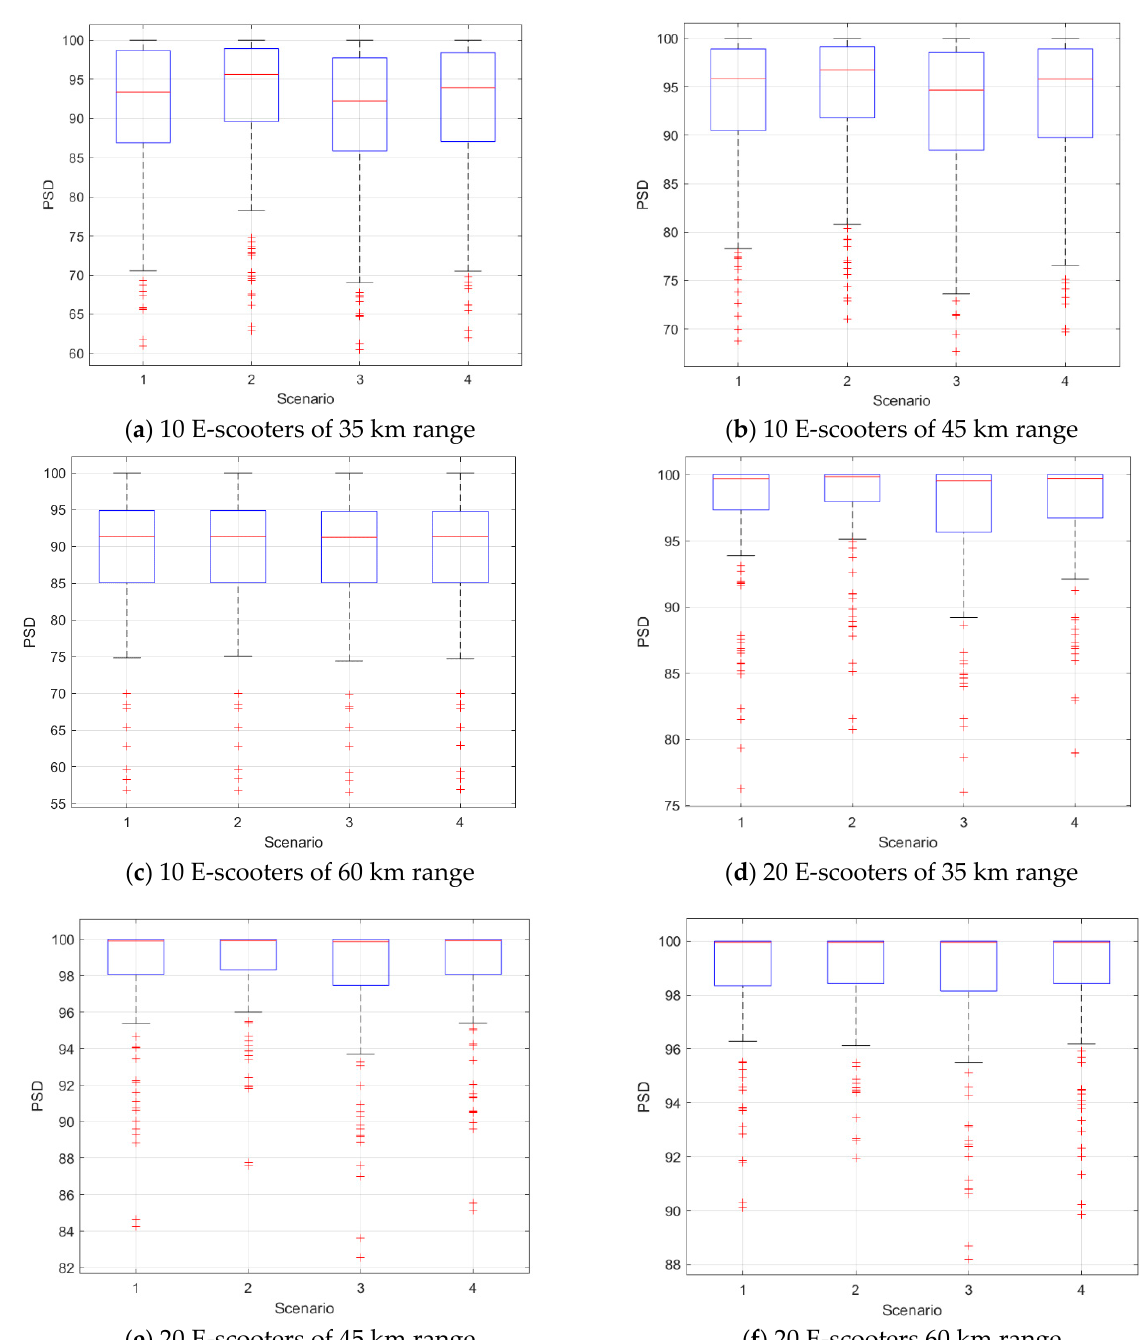
Figure 5. PSD results at different scenarios, number of e-scooters at each census tract, and battery ranges. Table 6. P-values of the scenario’s indicator variables for the PSD models.